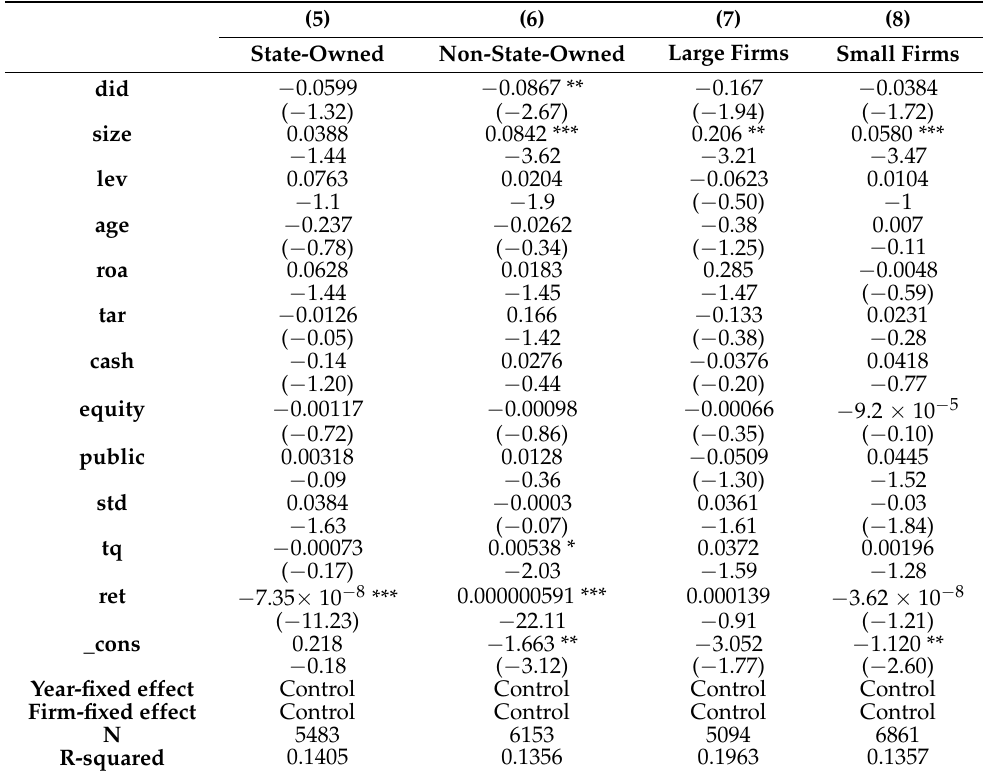
Table 4. Heterogeneity